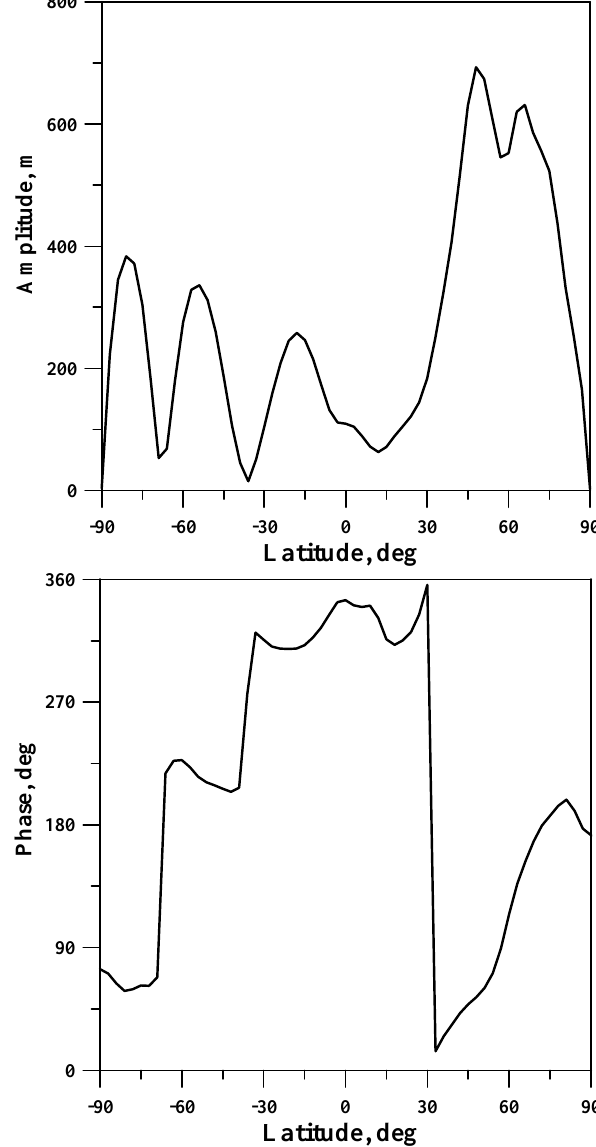
Fig. 7. Climatic distribution of the SPW1 amplitude, m (upper panel) and phase, deg (lower panel) in geopotential